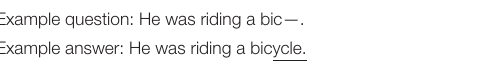
TABLE 2 | Example items in the Productive Vocabulary Levels Test. Example question: He was riding a bic—. Example answer: He was riding a